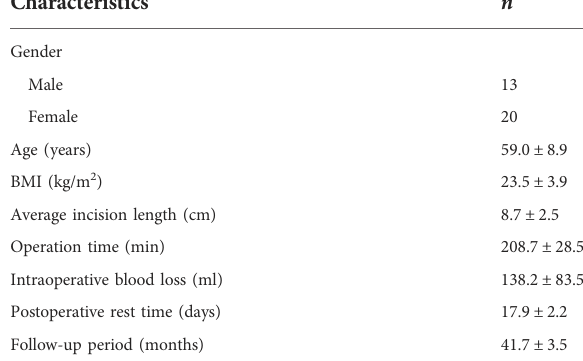
TABLE 1 Characteristics of